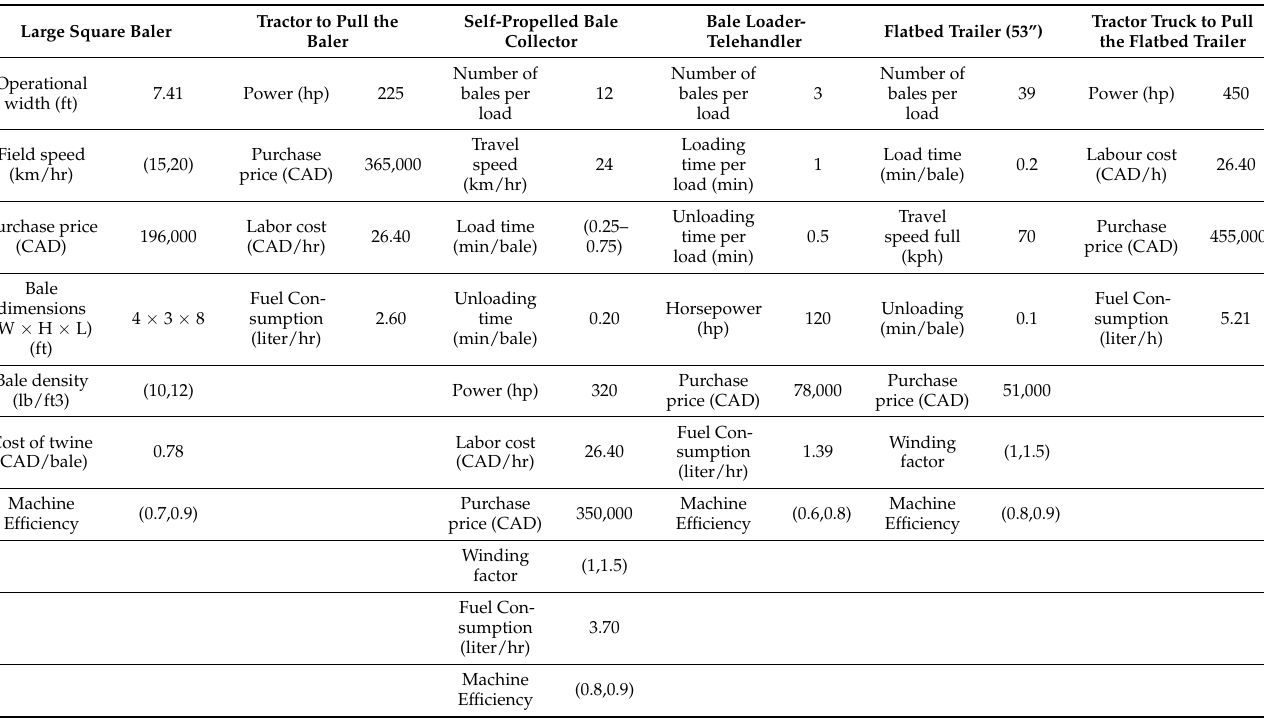
Table A1. Biomass logistics equipment data used in IBSAL-AgPellet.